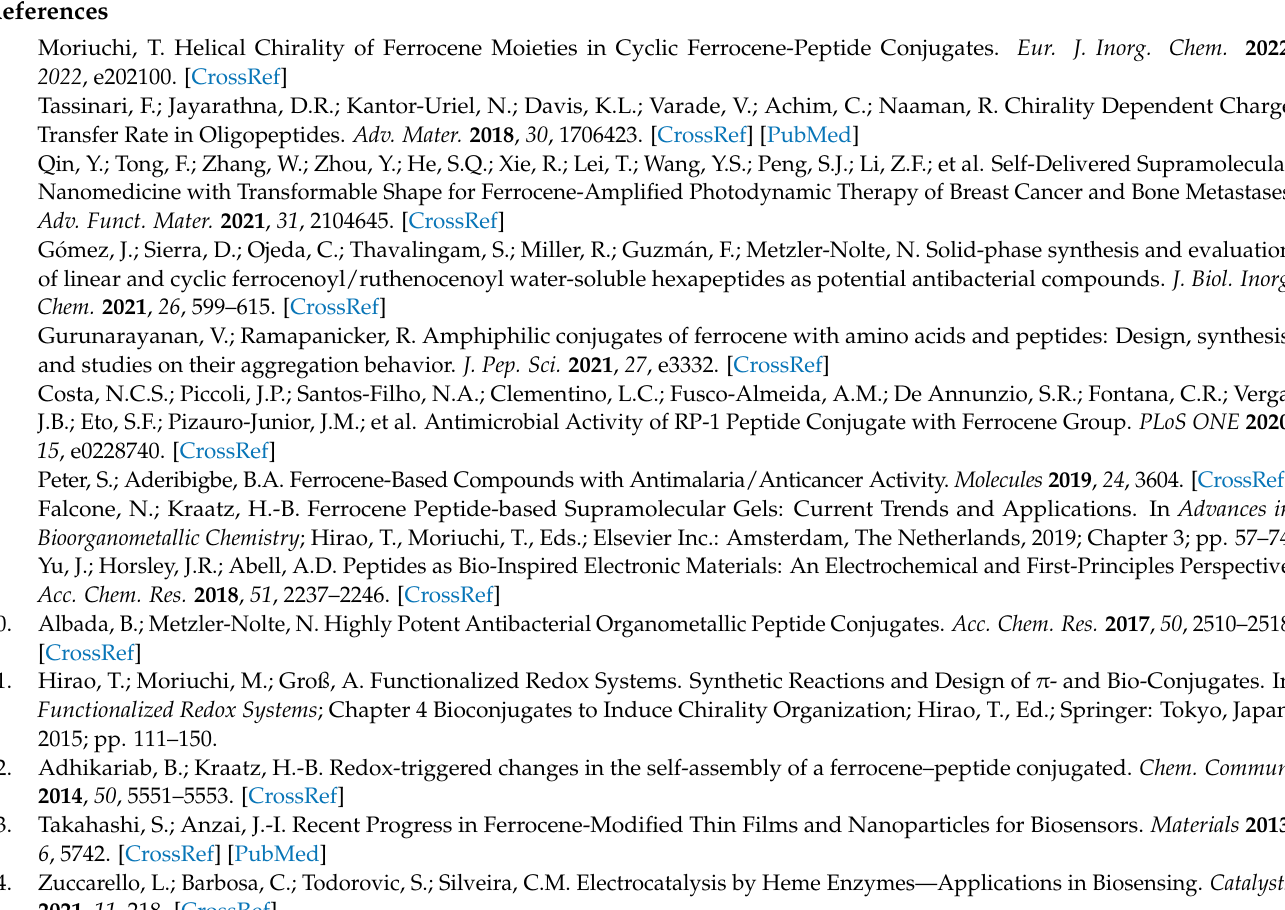
Figure S2. Absorption spectrum of ferrocene in the 300–600 nm region in cyclohexane solution; Figure S3. 3 10 -Helical models for 1–4